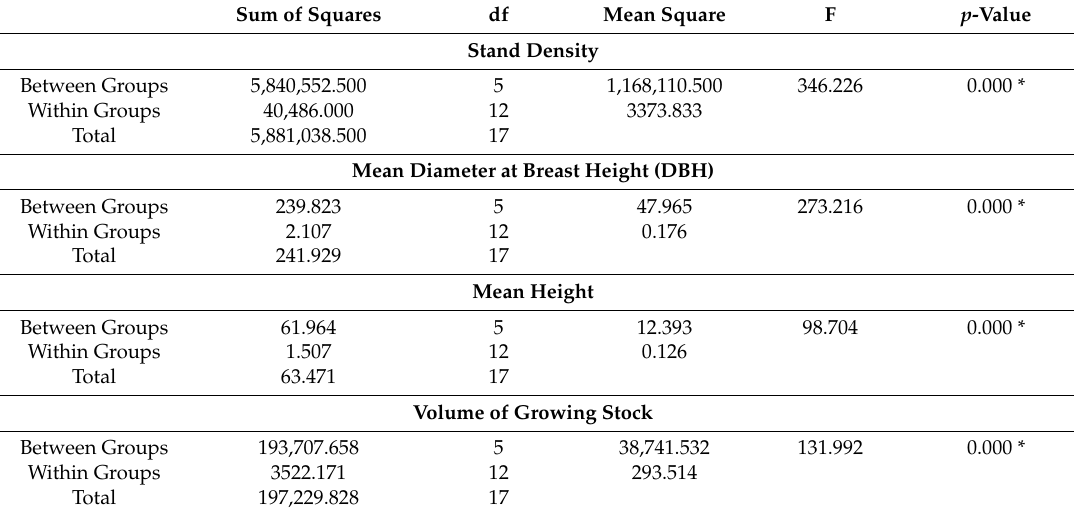
Table 1. ANOVA results on the impacts of harvesting intensity on the stands. Sum of Squares df Mean Square F p -Value Stand